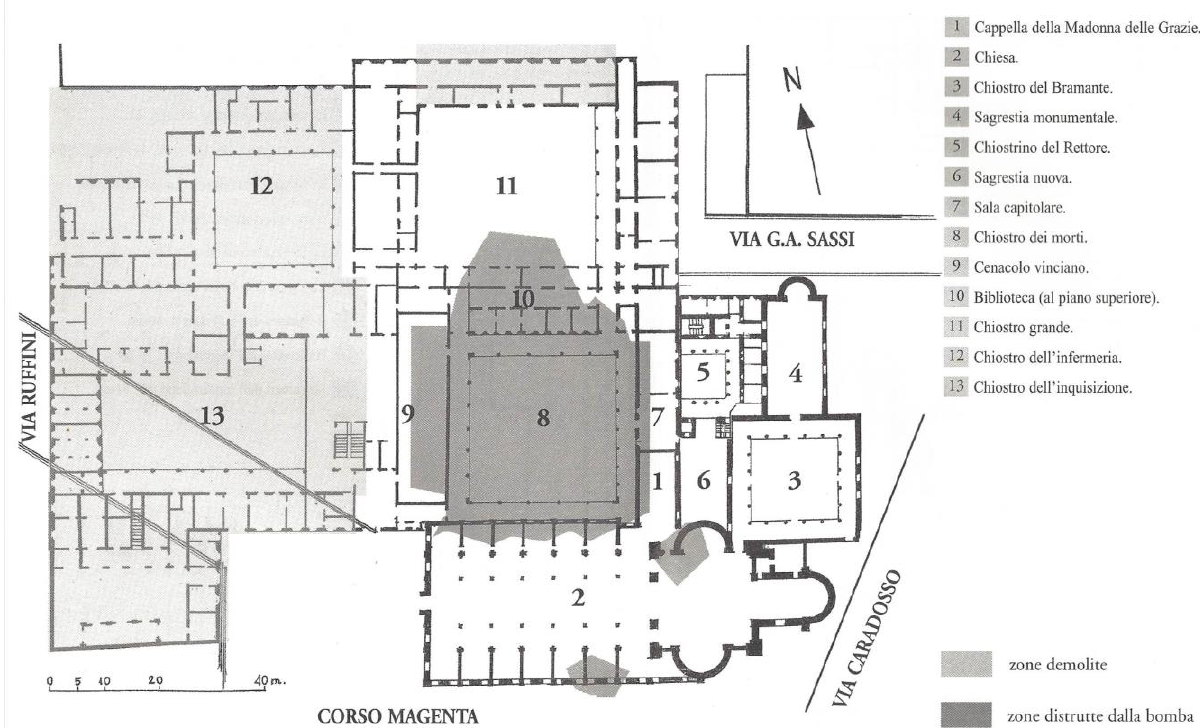
Figure 2. Plan of the convent of Santa Maria delle Grazie showing the parts destroyed during the bombing (Gattico G.,